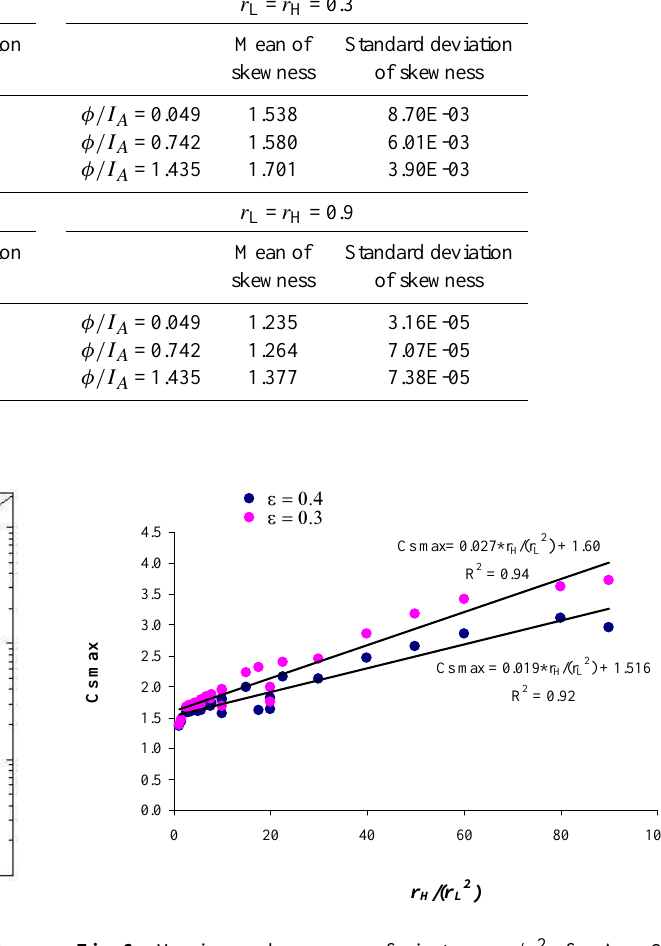
Fig. 5. Growth curves obtained for r L = r H =0.05 and varying φ/I A (as in the legend), W A /I A (as in Table 4), I 1 (10, 50mmh − 1 ), A (10, 50, 100, 200, 500km 2 ).